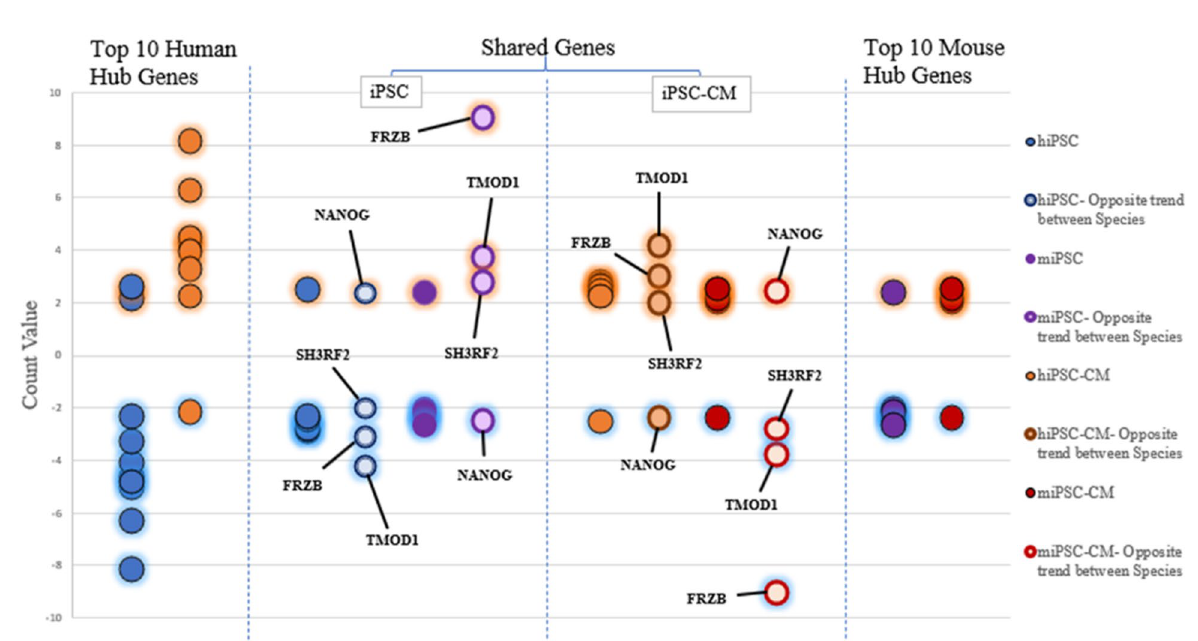
Fig. 6 Bubble plot showing up- and down-regulation of genes- This shows the top 10 human and mouse hub genes, as well as the shared DEGs between the data sets, and their count values for both the undifferentiated iPSCs and the iPSC-CMs. A blue glow behind the dots represents down-regulation of the DEG, while an orange glow represents up-regulation of the DEG. The four shared DEGs which express opposite trends between the human and mouse data sets are labelled (TMOD1, FRZB, SH3RF2, NANOG). Note: For the top 10 mouse hub genes, SREK1 is not plotted because it did not have an equivalent Official Gene Symbol in the conversion table, so its count values were unable to be